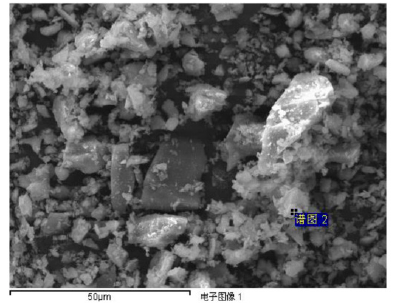
Figure 8. SEM image of test sand particles.